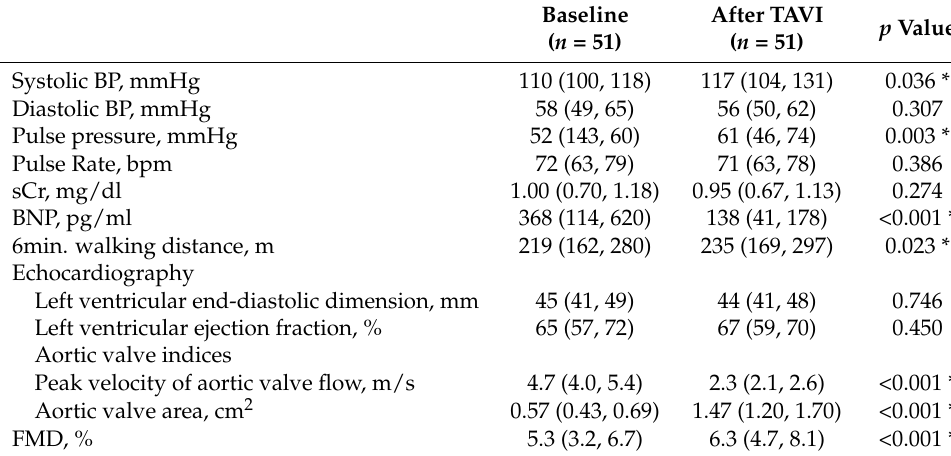
Table 2. Clinical parameters before and after TAVI.